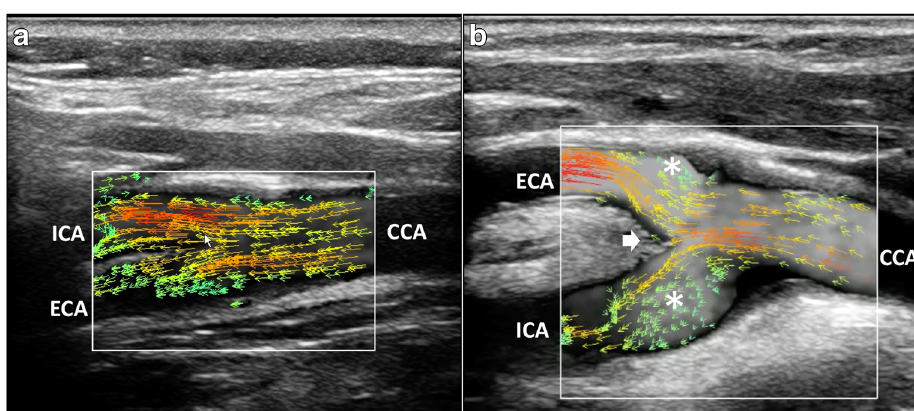
between ICA and ECA: streamline laminar flow ( red and orange vectors ) during systole. b ) Wide angle (> 45°) between ICA and ECA. The maximum velocity red vectors in the bulb hit the flow divider ( short arrow ), leading to the detachment of layers and generating vortex flow (*). CCA = Common carotid artery.